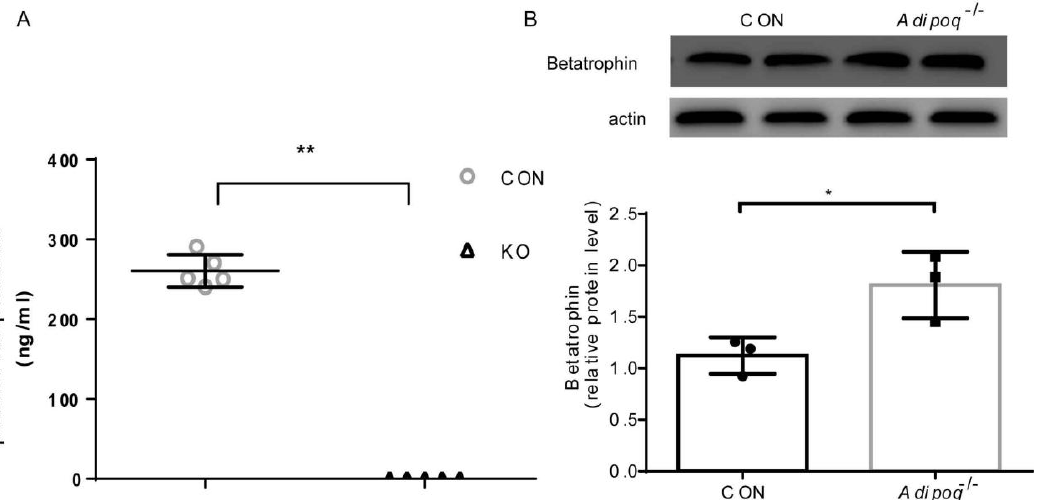
Figure 1. Effect of adiponectin knockout on betatrophin expression. ( A ) Plasma concentrations of adiponectin and betatrophin determined using ELISA at the end of the interventions (n = 6–8 in each group). ( B ) Western blot analysis of adiponectin and betatrophin expression in mouse liver. Data from at least three independent experiments are shown and are expressed as the mean ± standard deviation. Student’s t test: * p < 0.05, ** p < 0.01.